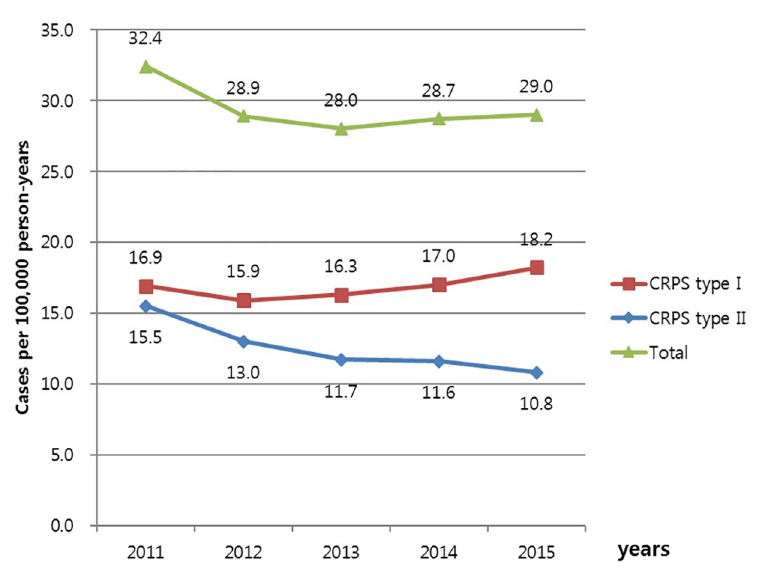
Fig 1. Incidence per 100,000 person-years from 2011 to